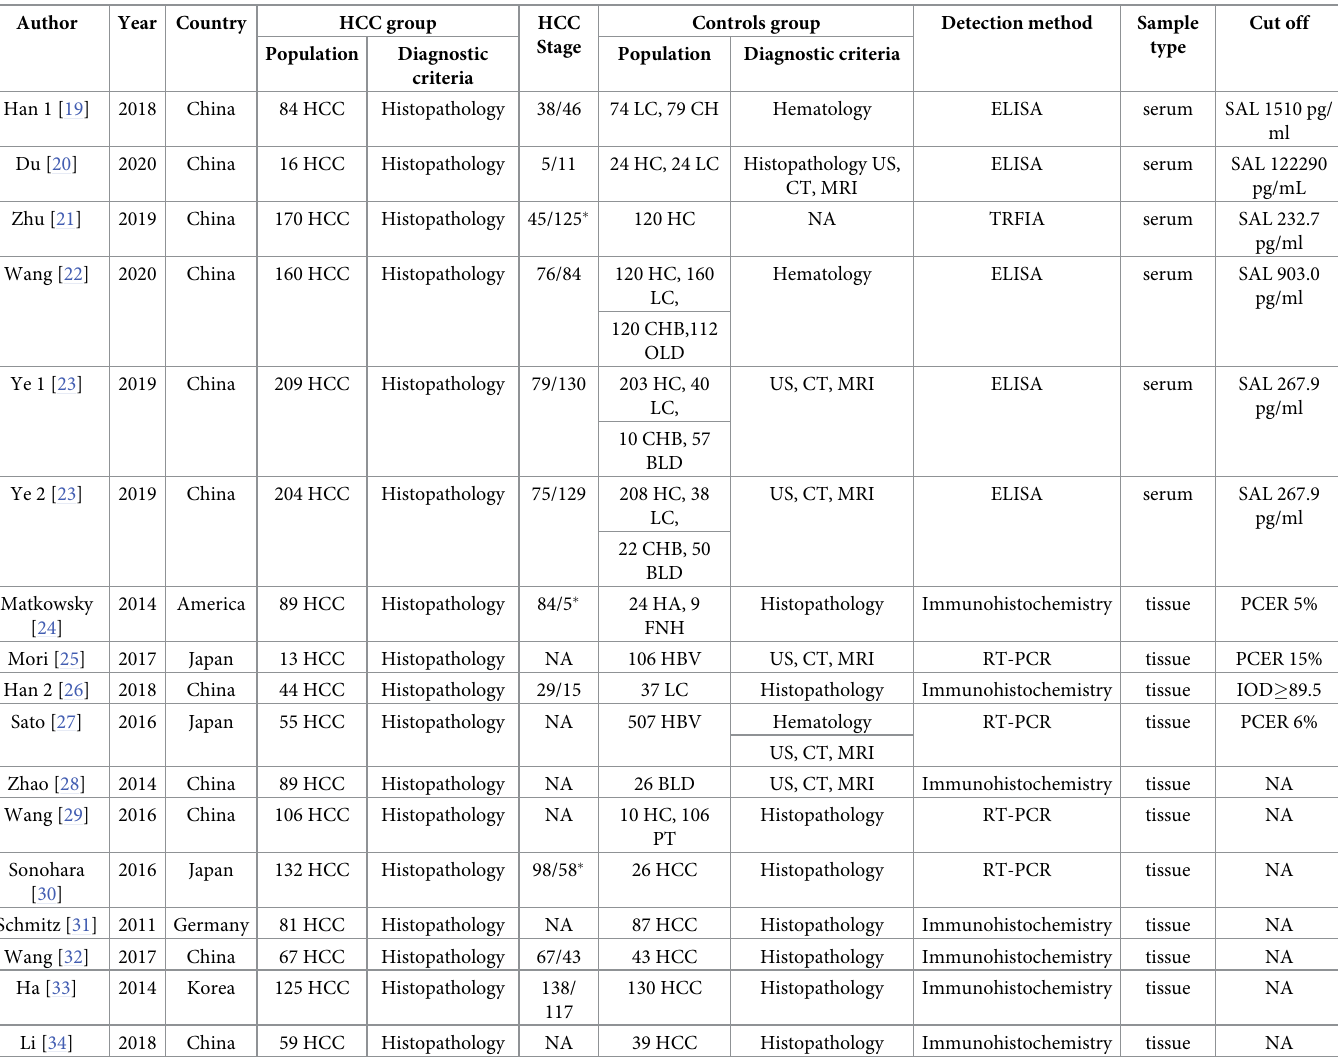
Table 1. Characteristics of the studies included in this meta-analysis.